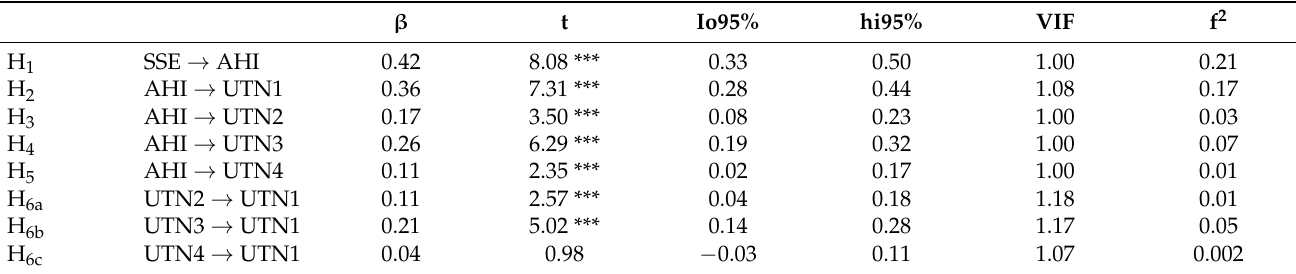
Table 4. Convergent validity and reliability.